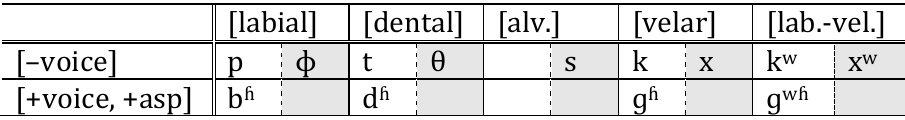
Table 11: The First Germanic Consonant Shift: stage 3 (after step 2).